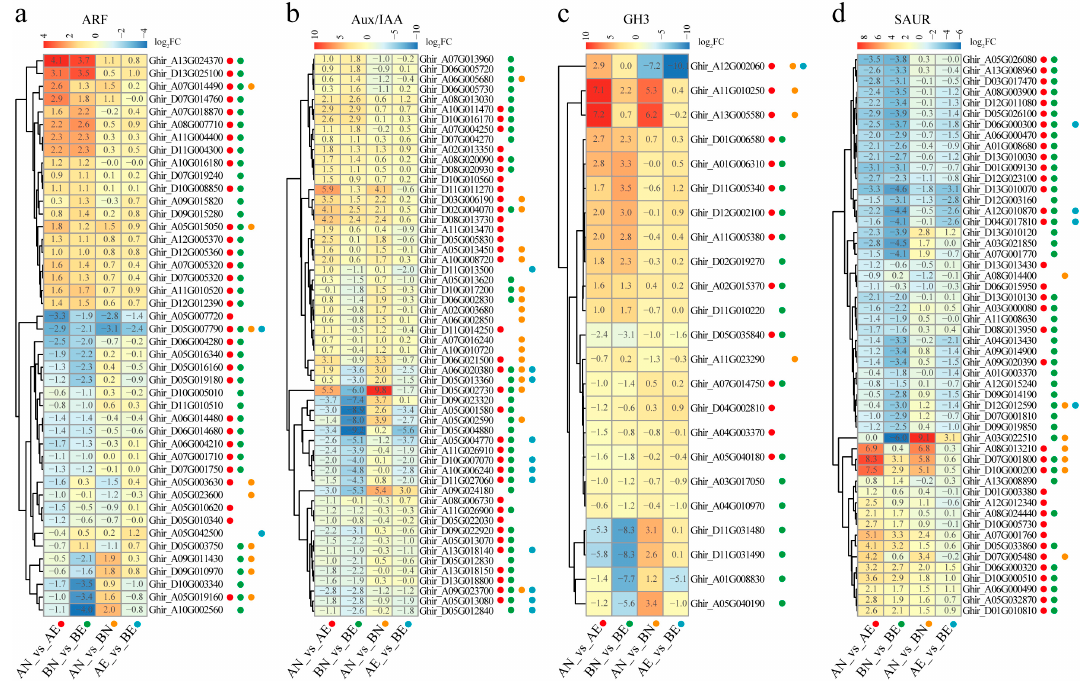
Figure 4. Schematic expression level change of differentially expressed ARF ( a ), Aux/IAA ( b ), GH3 ( c ), and SAUR ( d ) genes during transformation from NEC to EC. Numbers in grids indicate the log 2-transformed fold change (FC) values. Colored circle points beside the gene names indicate if the corresponding genes were significantly differentially expressed in AN_vs_AE (red), BN_vs_BE (green), AN_vs_BN (orange), and AE_vs_BE (blue) comparison pairs. Table2. Statisticsofdi ff erentiallyexpressed ARF , Aux / IAA , GH3 , and SAUR genesduringtransformation from NEC to EC in upland cotton somatic embryogenesis. Di ff erentially expressed genes (DEGs) were identified in four comparison pairs,